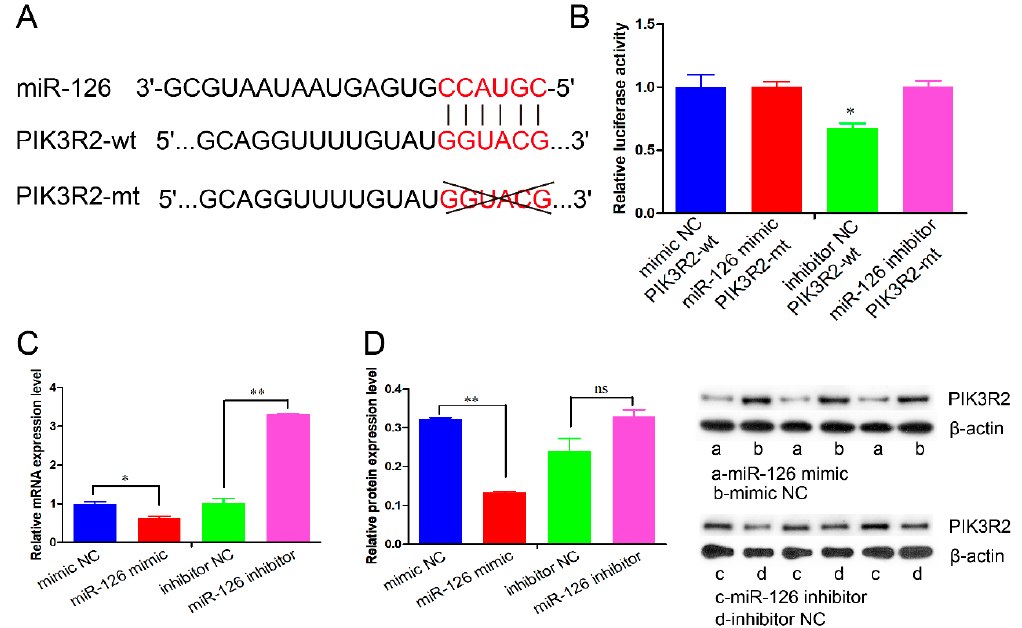
Figure 4. miR-126 directly targets the 3 ′ -UTR of the PIK3R2 gene. ( A ) A conserved target site for miR-126 was predicted in the 3 ′ -UTR of the PIK3R2 gene using the online software TargetScan 7.2. ( B ) The relative luciferase activity was measured in cells co-transfected with miR-126 mimic/mimic NC and PIK3R2 -mt/ PIK3R2 -wt. Renilla luciferase (Promega, Madison, WI, USA) activity was used as an internal control. ( C , D ) The effects of miR-126 overexpression and miR-126 inhibition on the mRNA ( C ) and protein expressions ( D ) of the PIK3R2 gene. The pig-TBP and β -actin gene were used as the internal controls in qPCR and Western blot assays, respectively. Data are presented as the mean ± SEM, * p < 0.05 and ** p < 0.01.